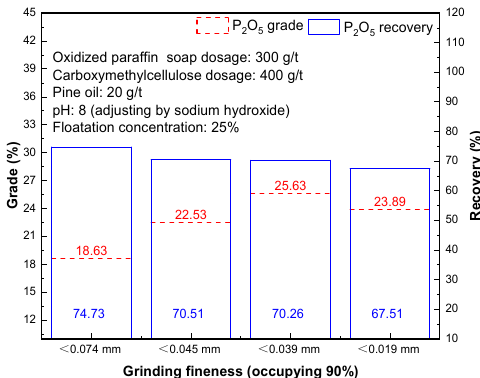
Figure 6. E ff ect of grinding fineness on extracting phosphorous. Figure 6. Effect of grinding fineness on extracting phosphorous.